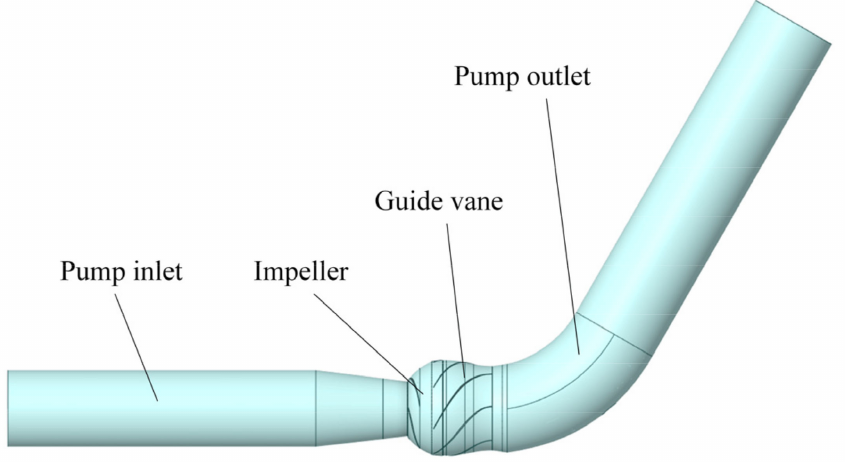
Figure 1. Computational domain of whole flow passage.